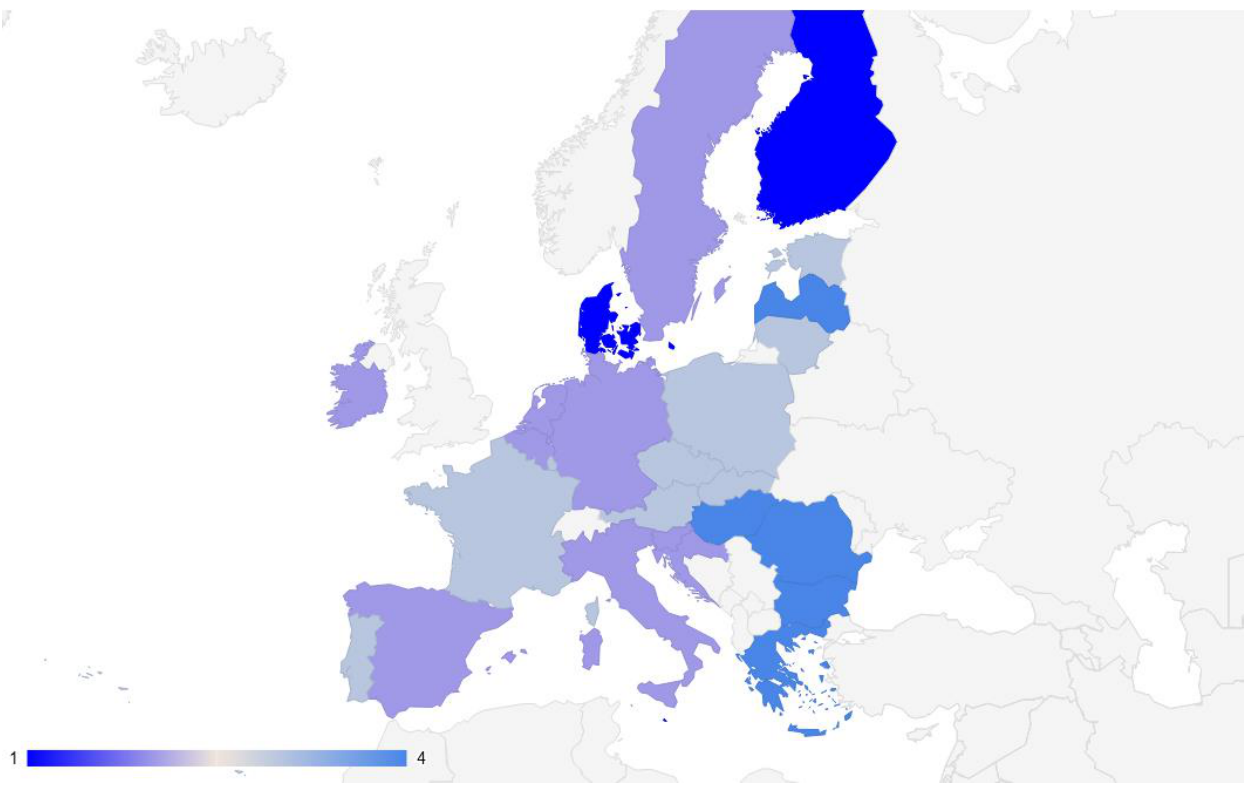
Figure 2. Division of the EU countries into four digital maturity classes (own elaboration).